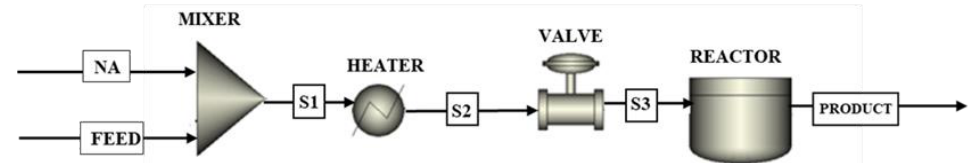
Figure 2. ASPEN Plus ® Flow sheet of a batch reactor process for the catalytic decarboxylation of naphthenic acid over HZSM-5 Process using batch reactor.